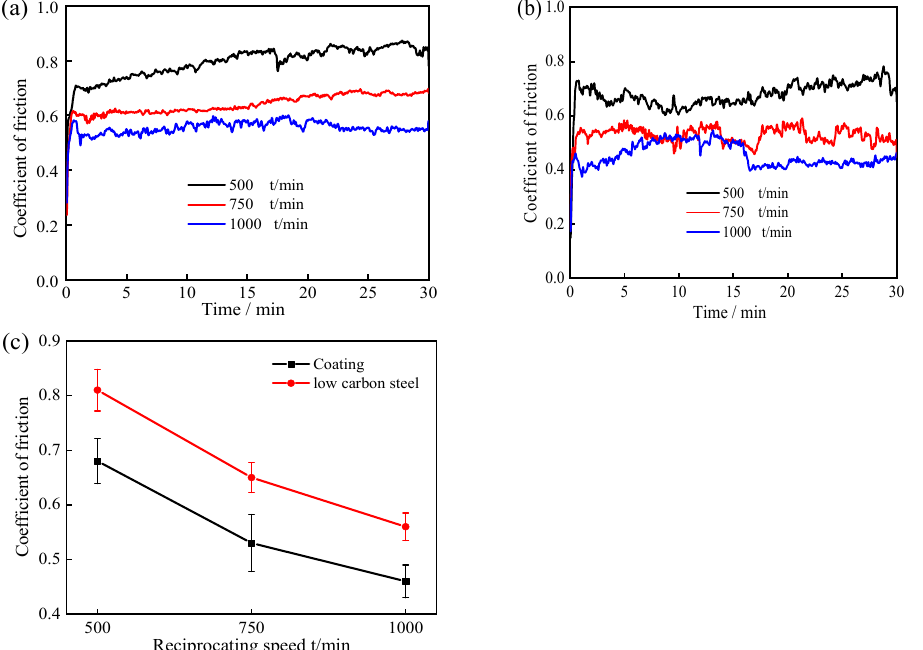
Figure 9. COF of the low-carbon steel and coatings at sliding speeds of 500 t/min, 750 t/min, and 1000 t/min ( a ) low-carbon steel; ( b ) Fe-based-Al 2 O 3 -B 4 C coating; ( c ) Average